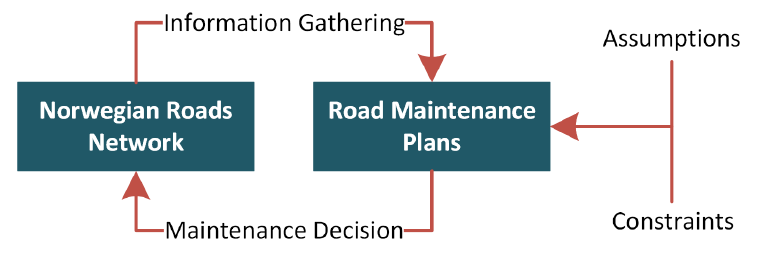
Figure 1. Conceptual design of PdM planning for road